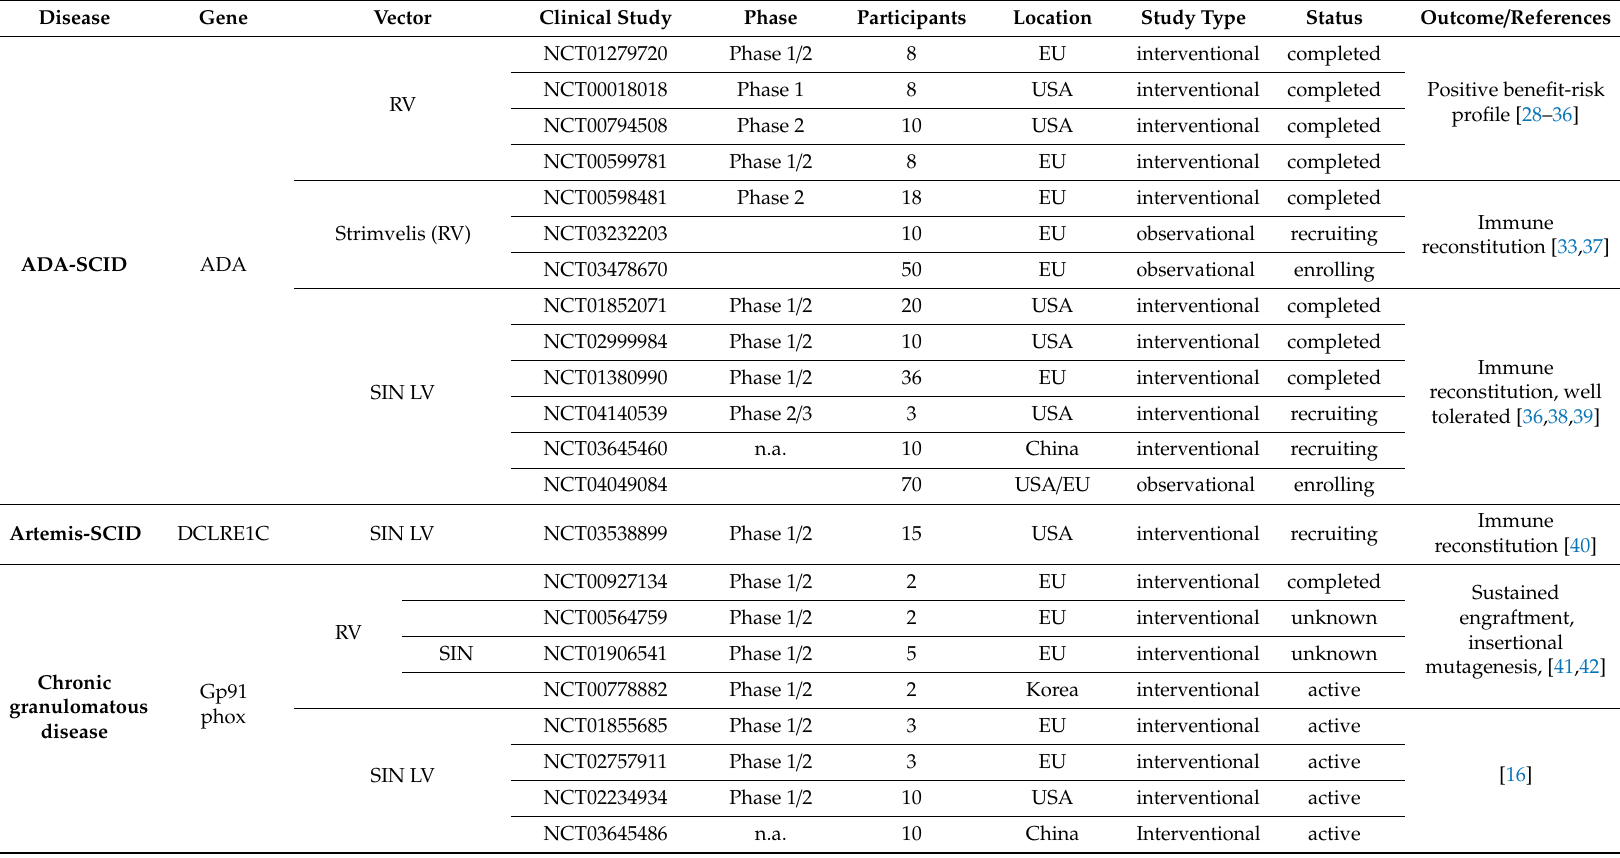
Table 1. Summary of finished and ongoing clinical trials for primary